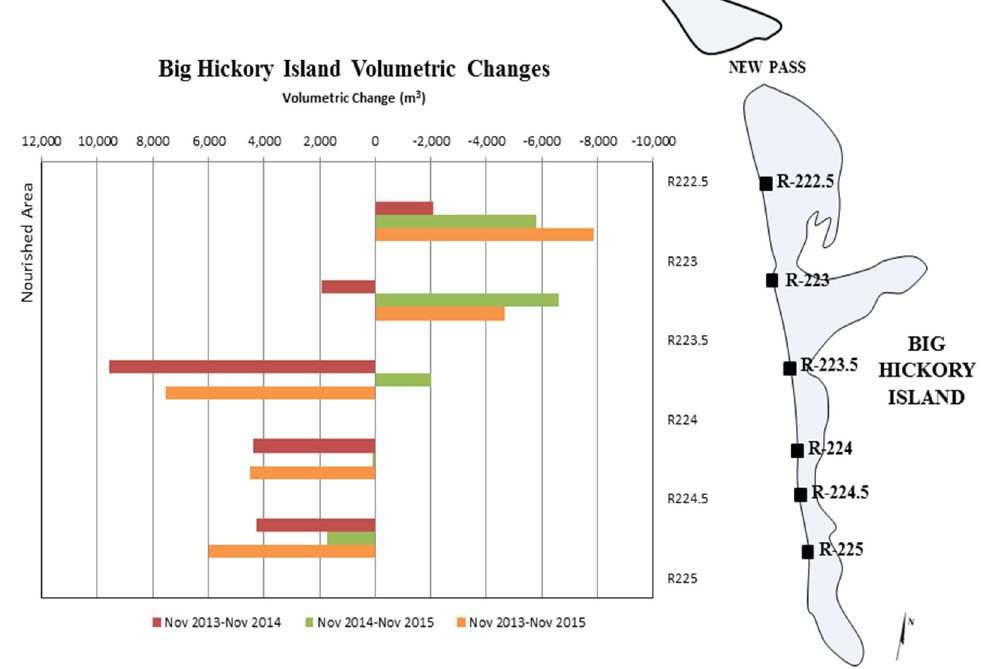
Figure 8. Time-series volumetric changes on Big Hickory Island, corresponding to FDEP Figure 8. Time ‐ series volumetric changes on Big Hickory Island, corresponding to FDEP R ‐ monuments (Nov 2013–Nov 2014, Nov 2014–Nov 2015, and Nov 2013–Nov 2015).